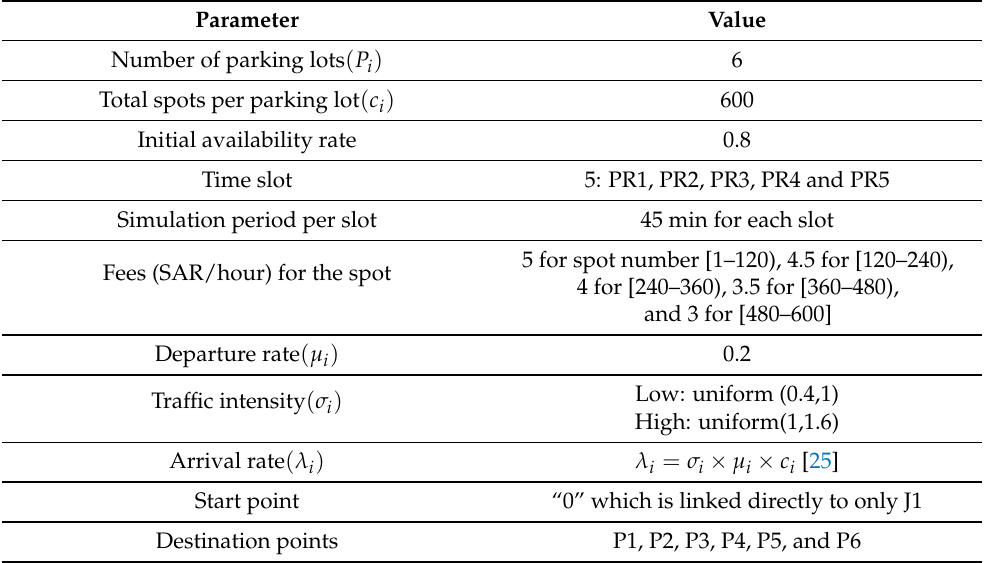
Table 2. Setting of the simulation parameters.